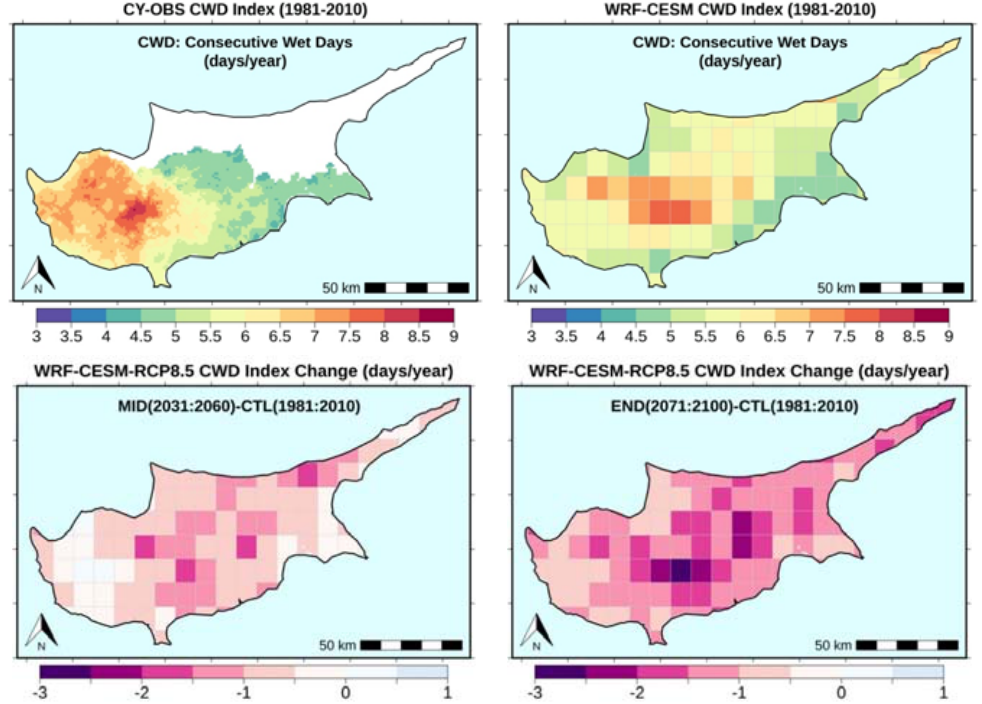
Figure 7. Observed ( top left ) and simulated ( top right ) maximum number of consecutive wet days per year (CWD) for the period 1981 to 2010 and projected changes for the middle ( bottom left ) and end of the 21st century ( bottom right ).